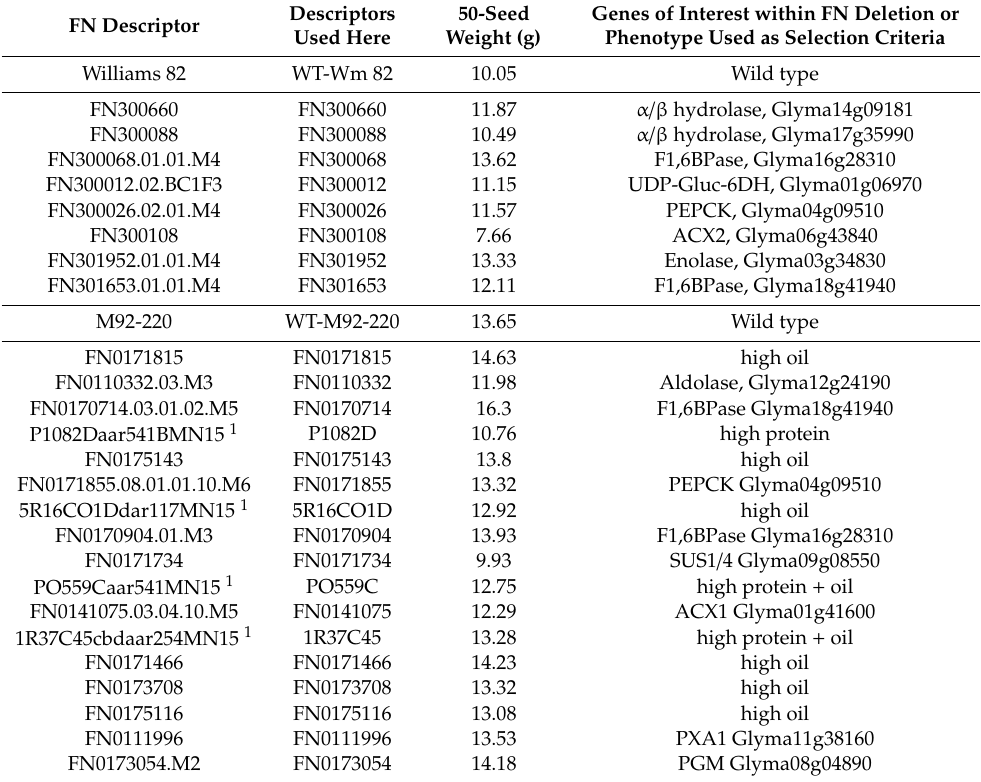
Table 1. Fast neutron (FN) mutagenized population used for preliminary oil and protein analysis in